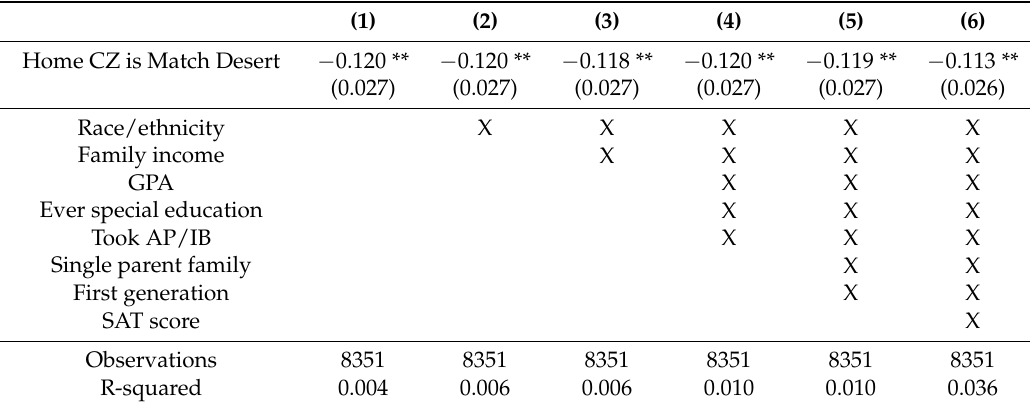
Table 6. Relationship between living in match desert and enrolling an academically-matched